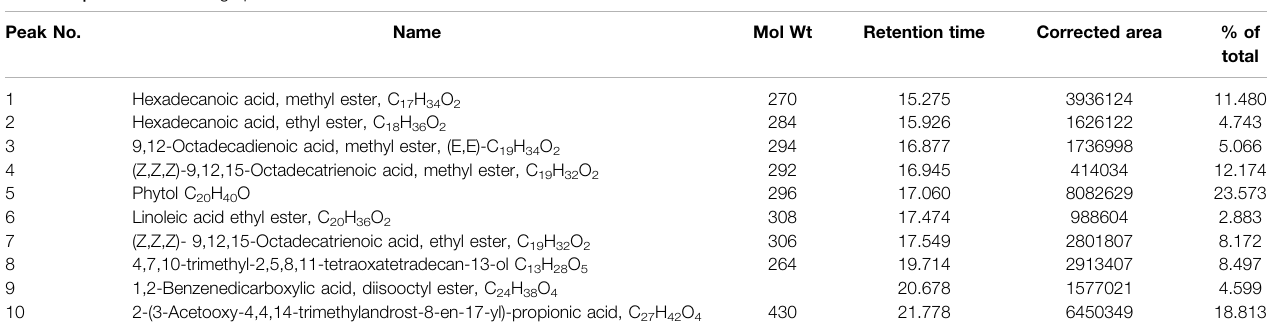
TABLE 2 | GCMS chromatograph of GREE. Peak